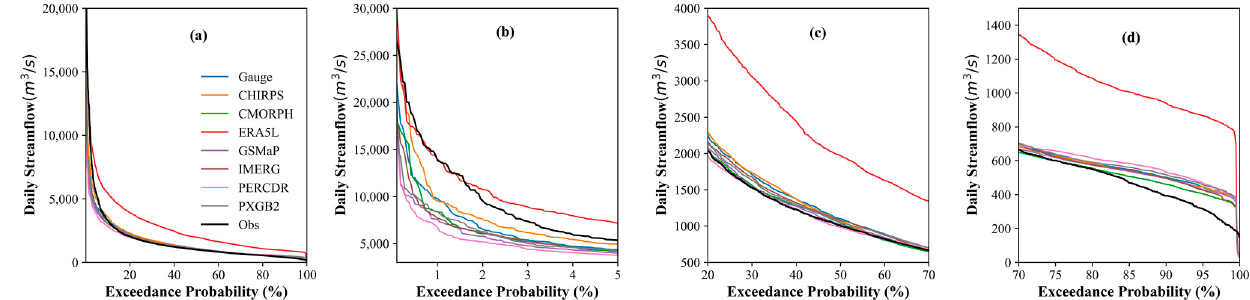
Figure 6. Comparison of observed and BTOP simulated daily streamflow using gauge observations and seven MSPs in calibration and validation periods under scenario I.